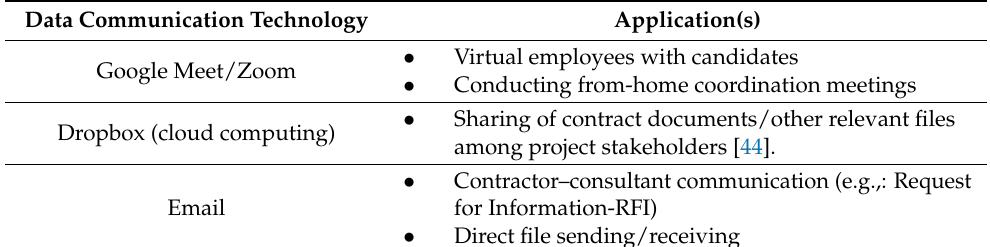
Table 3. Examples of applications of data communication